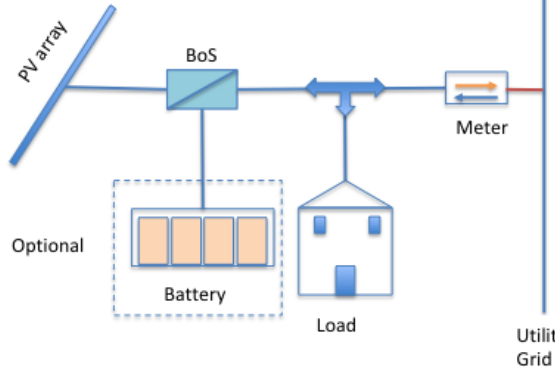
Figure 3. PV system distribution. Table 5. PV system component sizes.